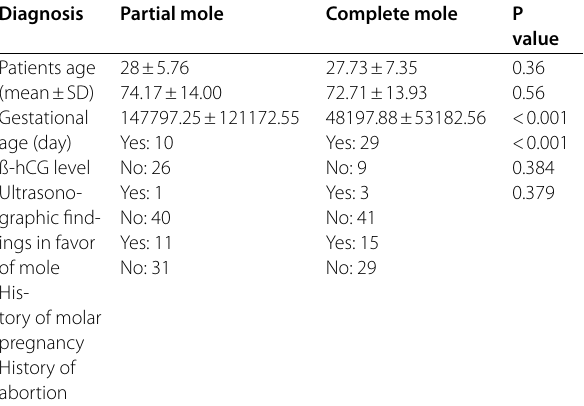
Table 1 Clinical features of the cases with hydatidiform moles Diagnosis Partial